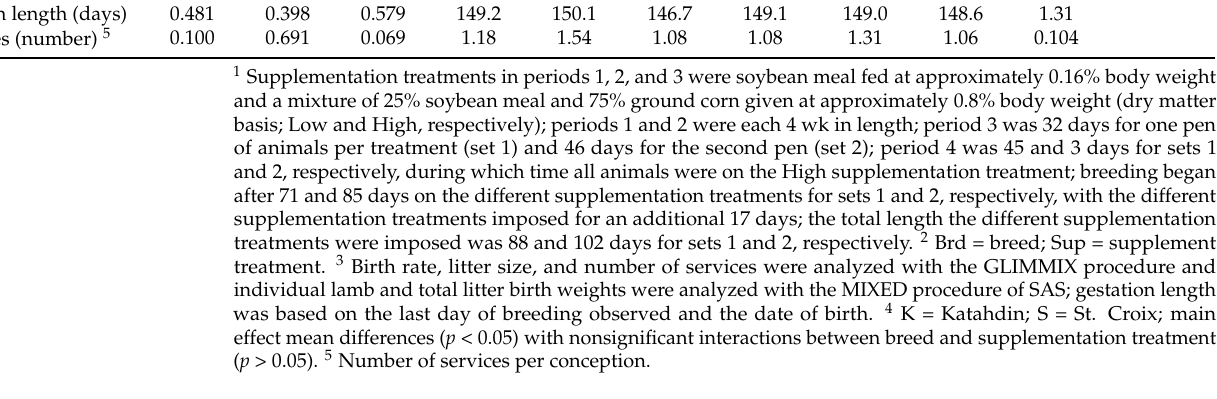
Table 5. p values for effects of breed, supplementation treatment, and period on heart rate and blood constituent concentrations in hair sheep 1 . Source of Variation